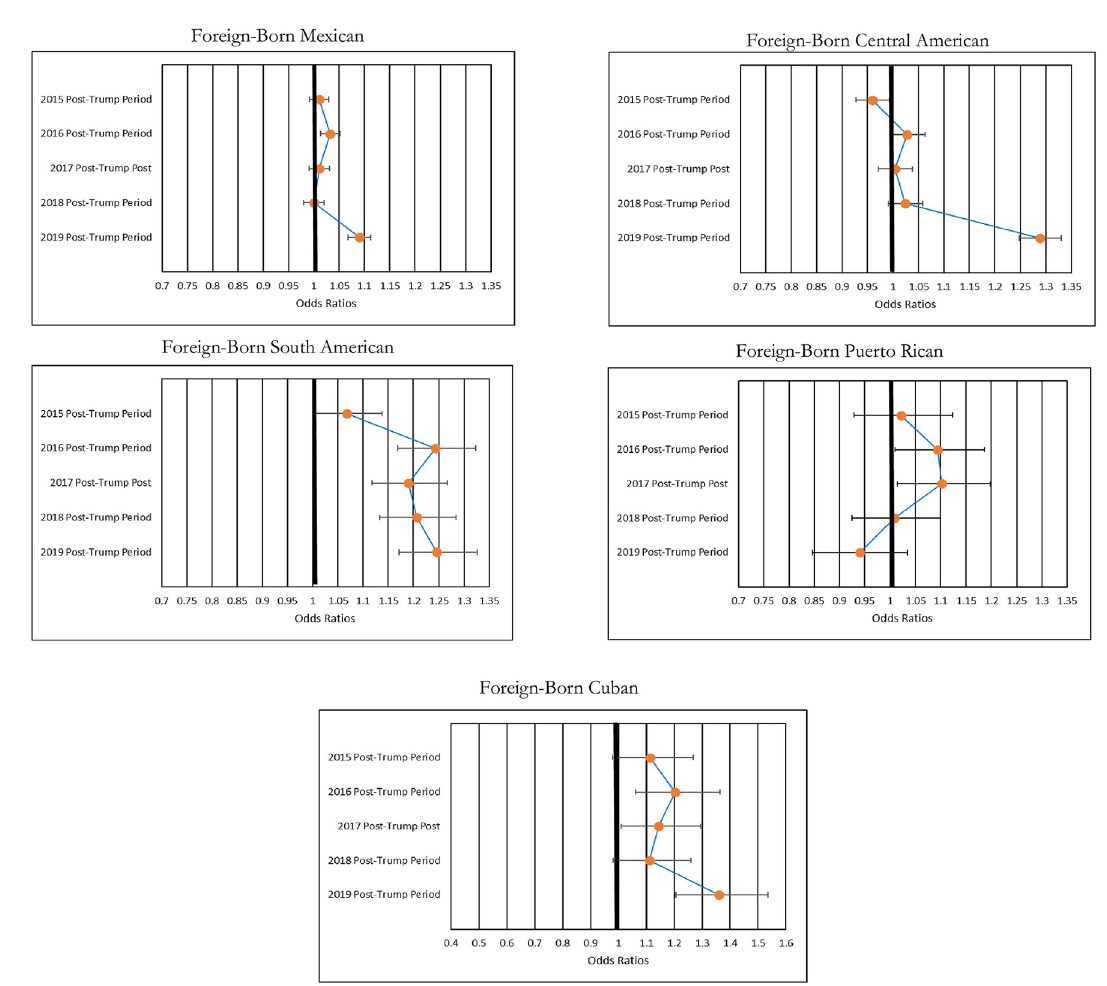
Fig 4. Adjusted odds of inadequate prenatal care, relative to pre-trump period by maternal country/region of origin.